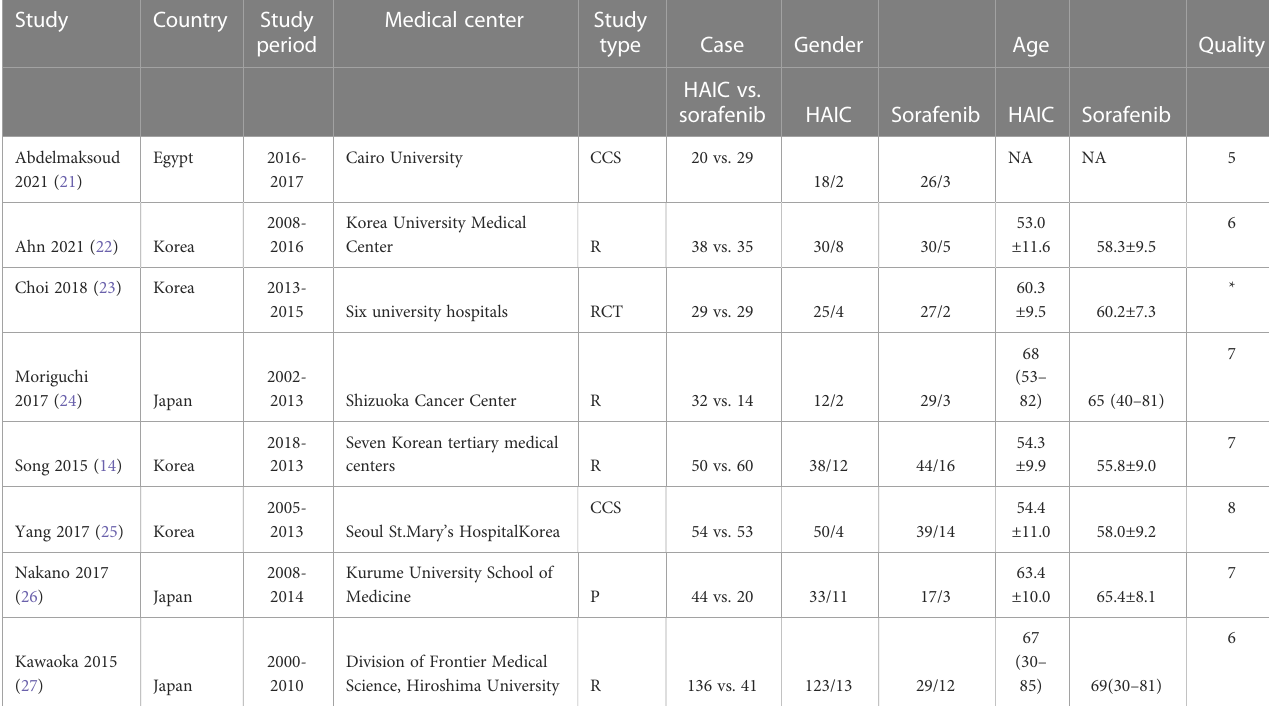
Vp3) had better prognoses than patients with terminal portal veins (Vp2), with higher DCR rates, lower PR rates, and higher OS and DFS. The results are presented in Table 5.